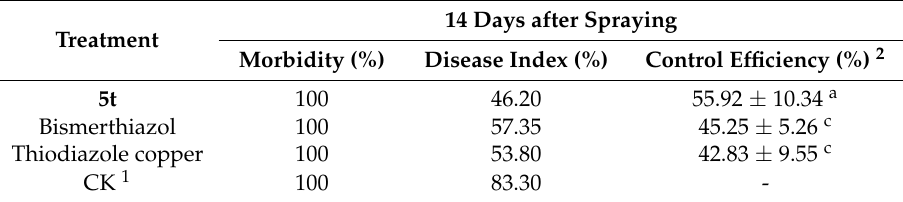
Table 6. Curative activity of compound 5t against rice bacterial leaf streak.